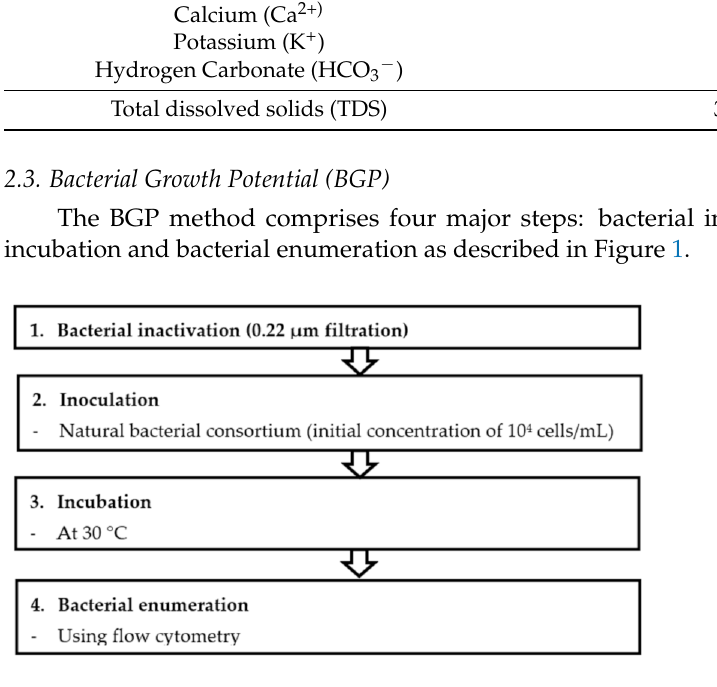
Figure 1. Procedure for measuring bacterial growth potential (BGP) in seawater using flow-cytometry method